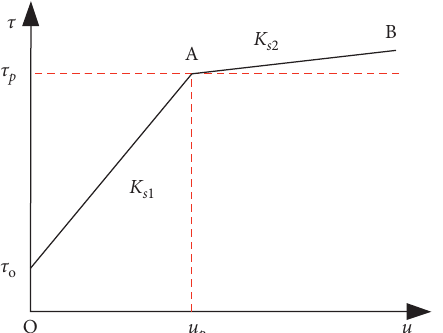
Figure 7: Relationship between the interface shear stress and the displacement of the bilinear ( τ − u ).